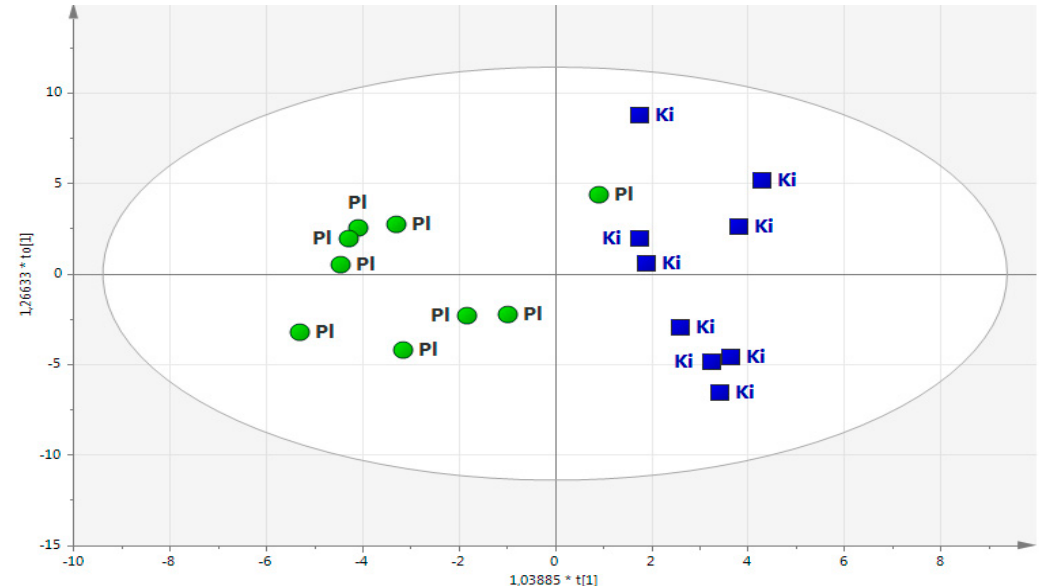
Figure 1. OPLS-DA score plot based on each individual’s metabolic profile. (R 2 X = 0.19, R 2 Y = 0.57, Q 2 Y = 0.18). Note: Round circles indicate the men that received the placebo (Pl, green; n = 9), and the squares are men treated with SeQ 10 (Ki, blue; n = 9). Note: The metabolite pattern was determined in plasma at the time point of 18 months (T 18 ). Note: One of the individuals receiving placebo took SeQ 10 by self-administration.